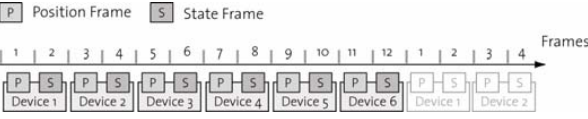
Figure 6. A complete frameset of 6 devices with their specific timeslots